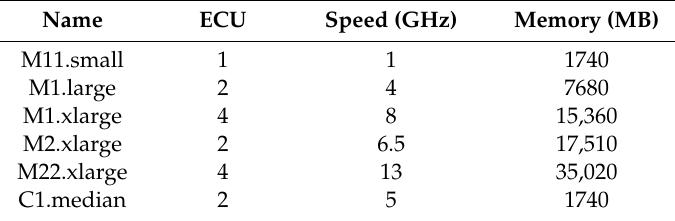
Table 4. Virtual machine request